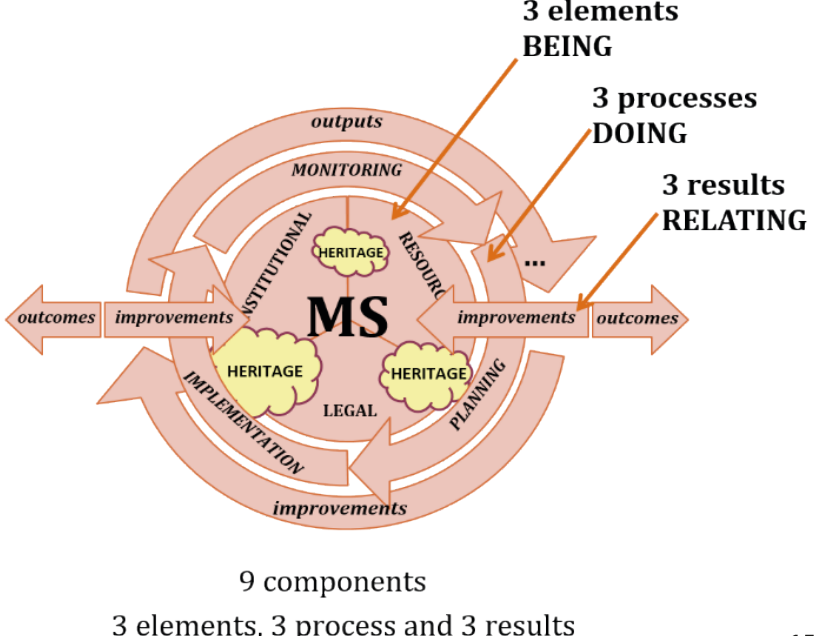
Figure 15 Management System (Source: Wijesuriya et al. 2013).